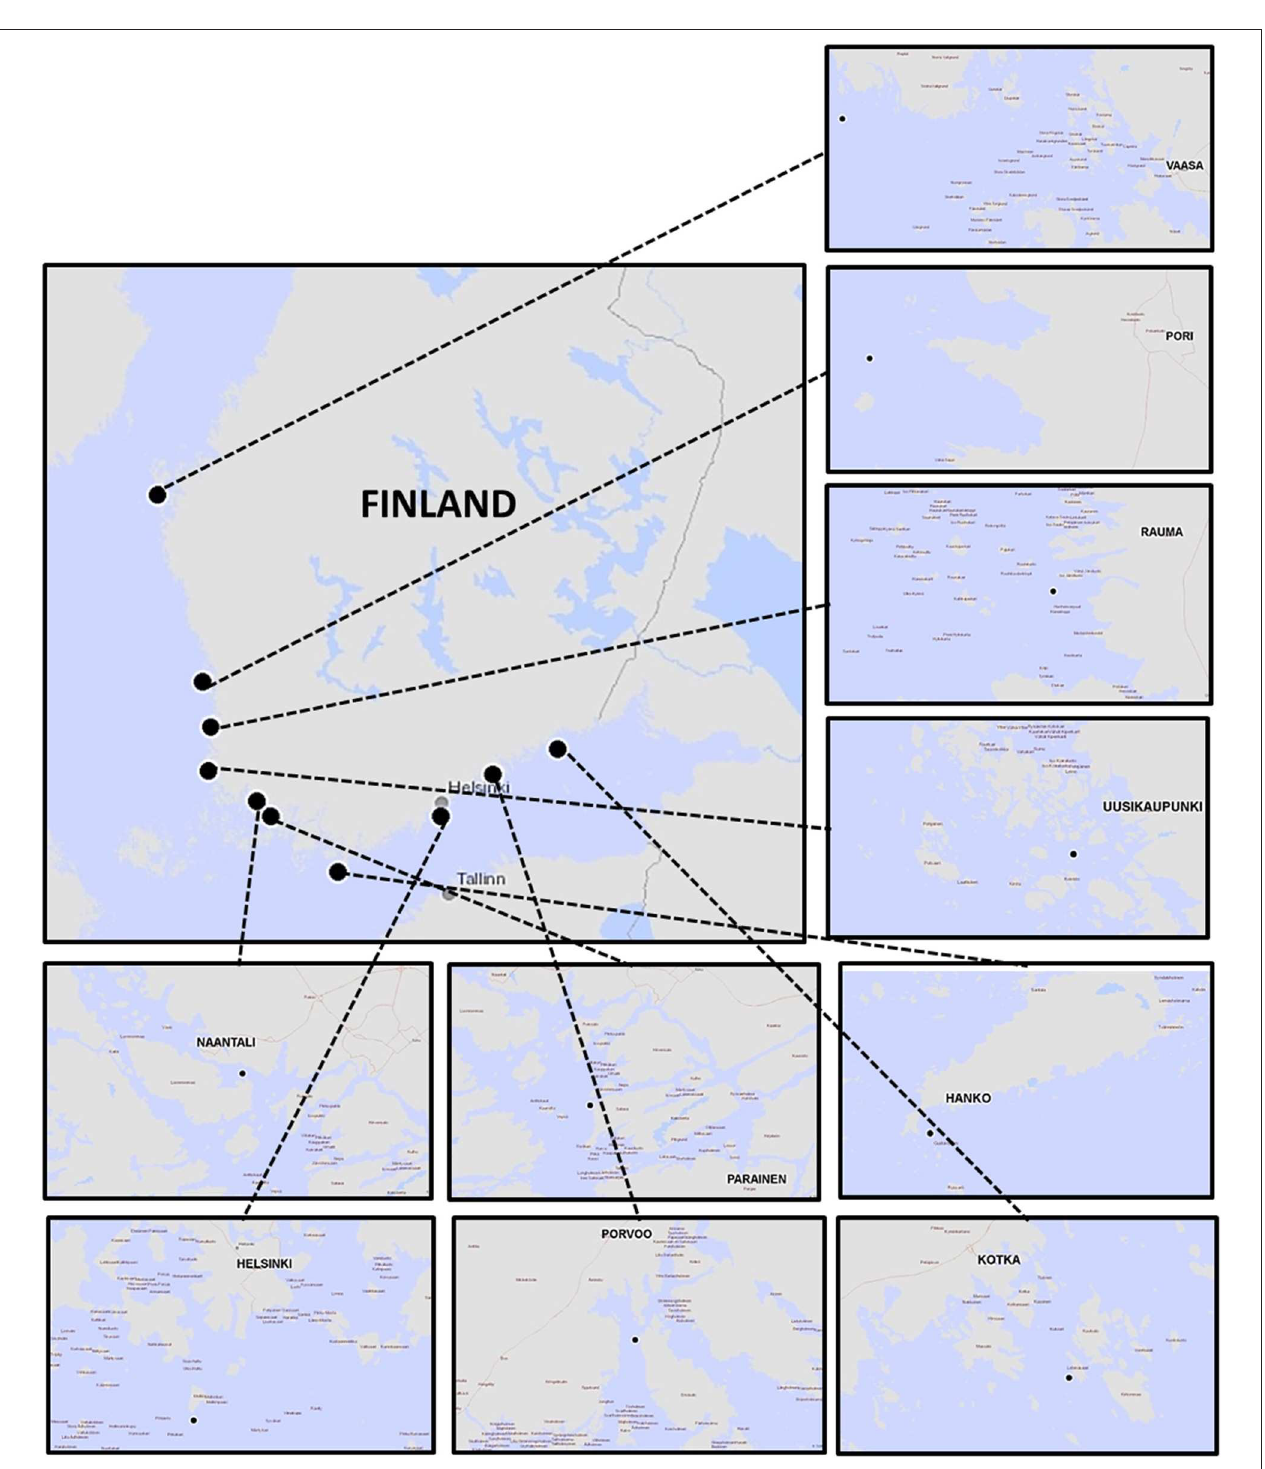
FIGURE 1 | Study sites along the coast of Finland. The black dot in each site map represent the exact site of the mussel cage. boxes (mesh size of 10 × 10 mm) in which the mussels (ca. 200 The mussel cages were constructed of stainless steel and had individuals per cage) were randomly distributed. The cages were a rectangular shape (height 60 cm, width 40 × 40 cm). Within deployed at the water depth of 7–8 m, anchored to the the frame structure there were five easily removable steel net